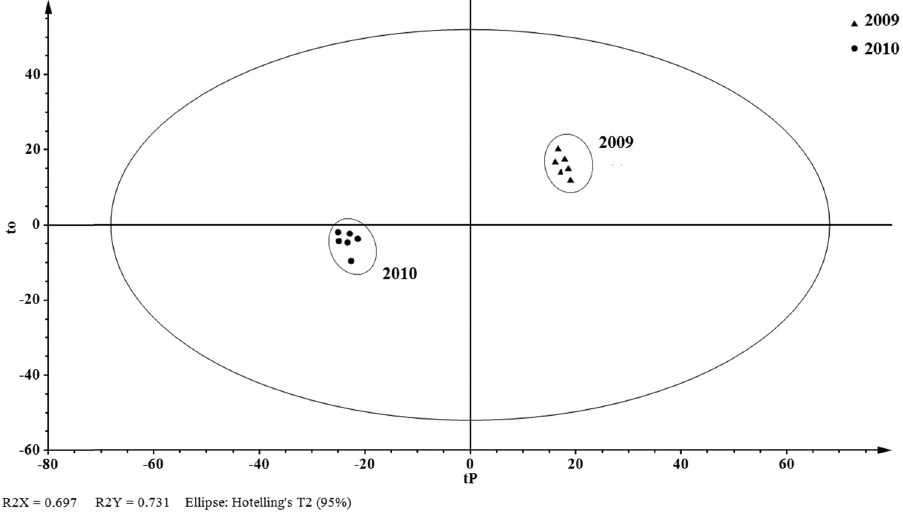
Figure 4: OPLS - DA score plot chart from 1 H NMR spectra of 2009 and 2010 vintage Cabernet Sauvignon wines.